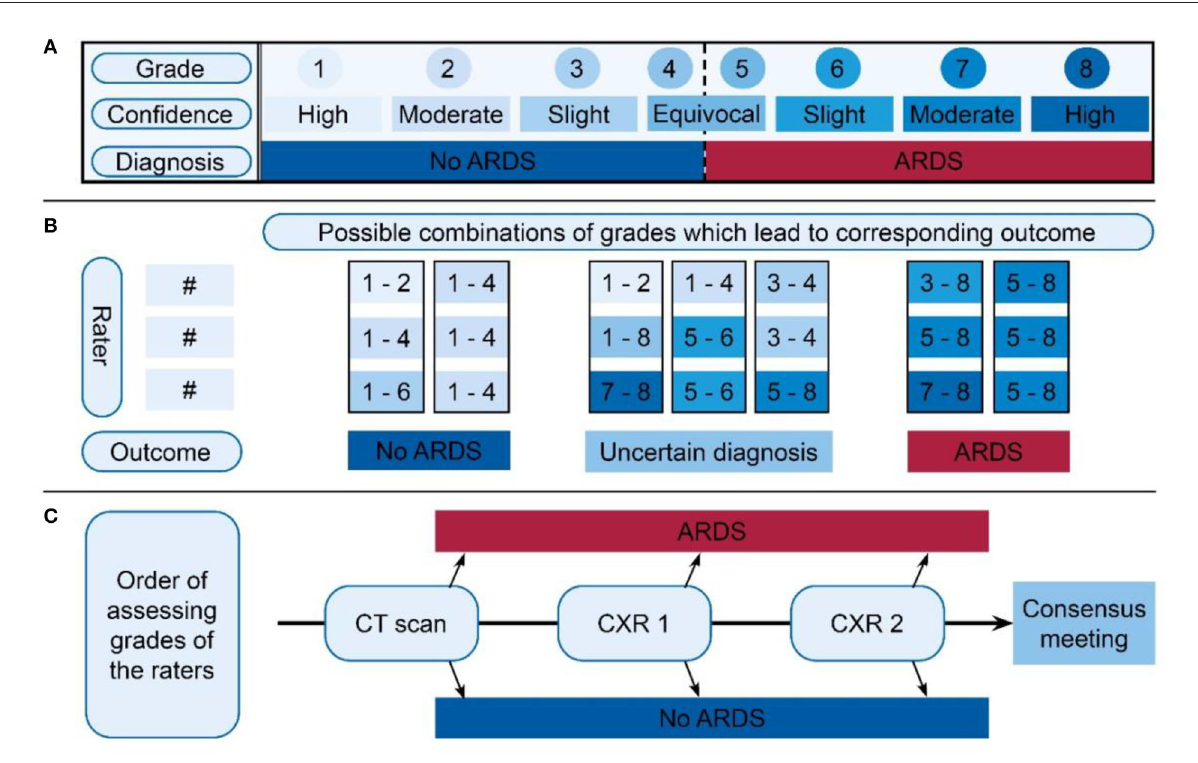
FIGURE1 Overview of ARDS scoring and classification, divided into three parts. (A) The 8-grade confidence scale on which the expert scored a certain grade for each available image. The upper row displays the grades the expert scored, where the middle row indicates how the confidence of this grade should be interpreted. The row below indicates the corresponding diagnosis. (B) Schedule for indexing final classification of ARDS diagnosis. Based on the three grades of the expert panel (three times a value between 1 and 8), a subject was classified in one of the three outcomes: “No ARDS,” “Uncertain diagnosis,” or “ARDS.” The option bars above the outcome indicate the grades given by the experts. The figure shows possible combinations between the three raters in the vertical direction. The boxes show the values that were allowed to come to a score of ARDS or no ARDS. When there was uncertainty between the raters or highly confident conflicting scores, an uncertain classification was given. (C) Order of assessing the available grades. For the first CT, if a definitive outcome was available, this was regarded as the final decision. If no was CT available or there was no definitive outcome, the grades of CXR1 were assessed. If this did not give a definitive outcome, the second CXR grades were assessed. Also, if no definitive outcome was available, one should proceed in the direction of the arrow, ending up in the “consensus meeting.” Importantly, this was not the order in which the images were scored by the experts. ARDS, acute respiratory distress syndrome; CXR, chest